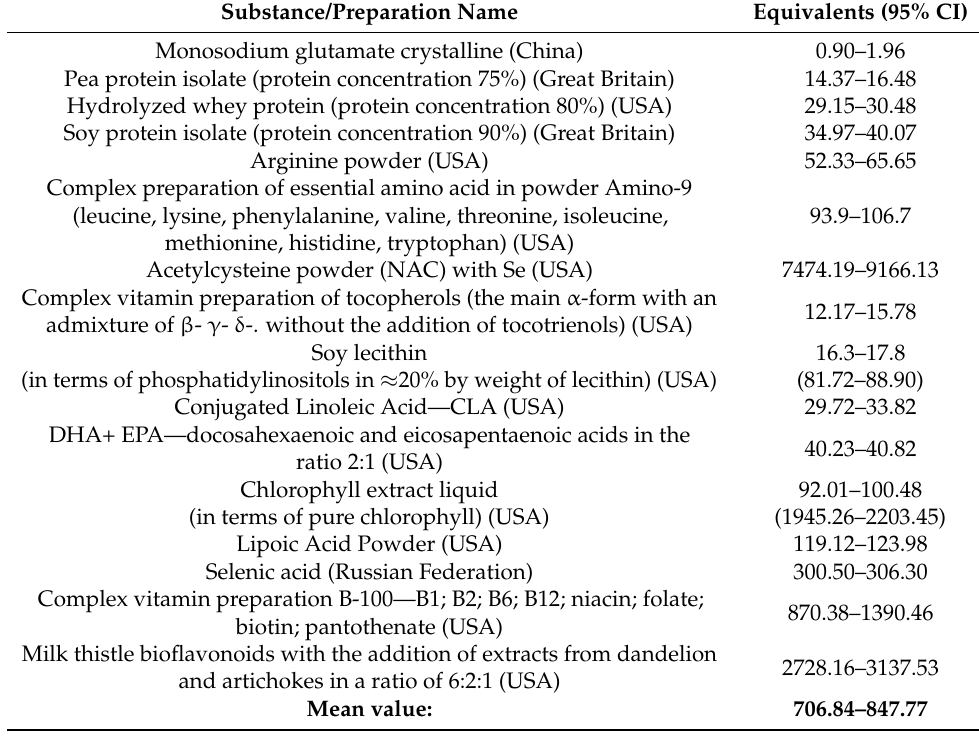
Table 2. ARP of products widely used in the food industry, including biologically active substances, vitamins, hydrolysates, extracts, and mineral